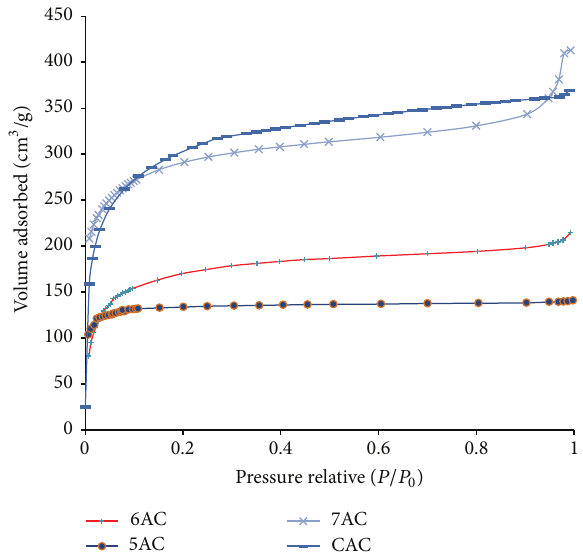
Figure 2: Results of adsorption isotherms of all the